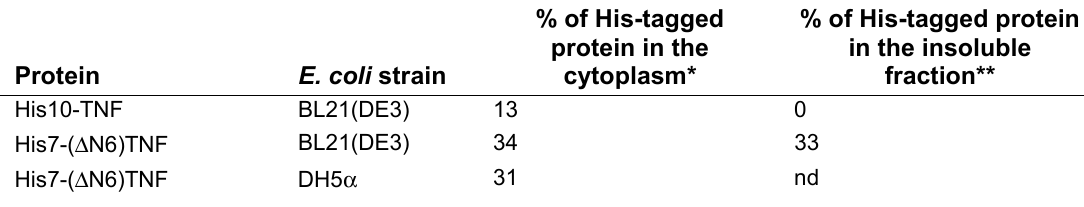
Accumulation of His-Tagged TNF Proteins